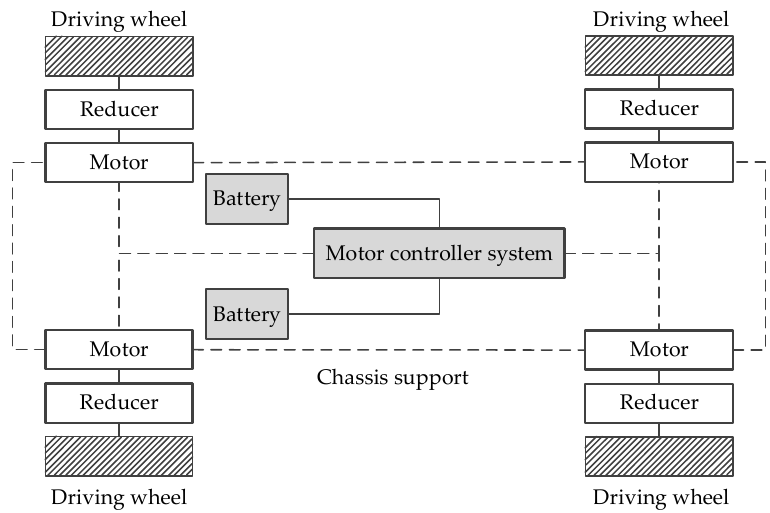
Figure 2. Structural diagram of four-motor four-wheel distributed independent drive system.